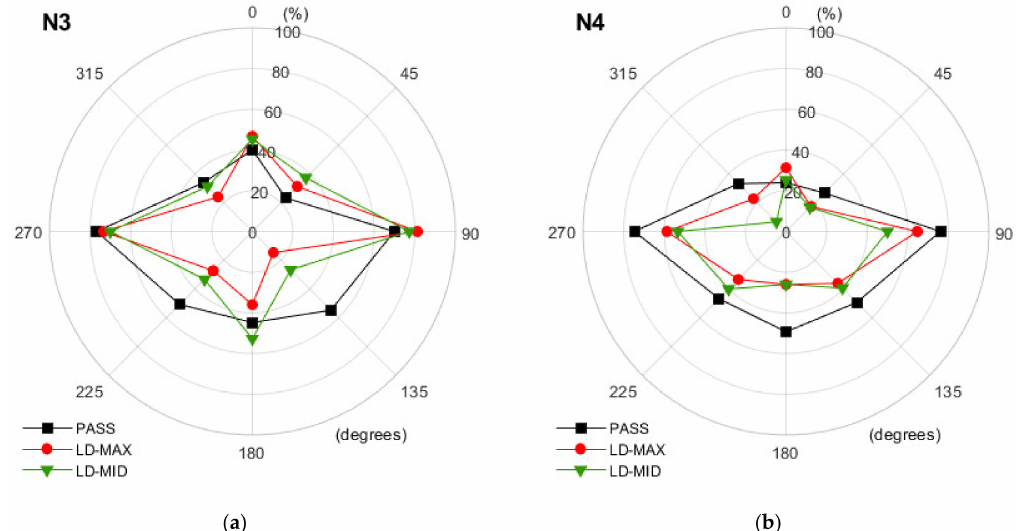
Figure 8. The values of the direction recognition index determined for different directions when using earmuffs in different modes: ( a ) N3 and ( b ) N4. PASS—with the level-dependent system switched off. LD-MAX—level-dependent mode, with maximum amplification in the sound transmission path; LD-MID—level-dependent mode with the amplification set to incomplete (approximately half).